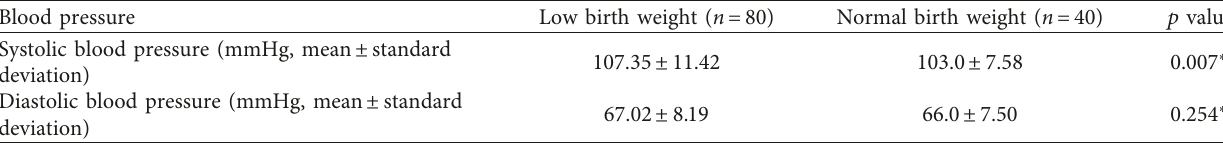
Table 3: Association between children with low and normal birth weight with systolic and diastolic blood pressure.